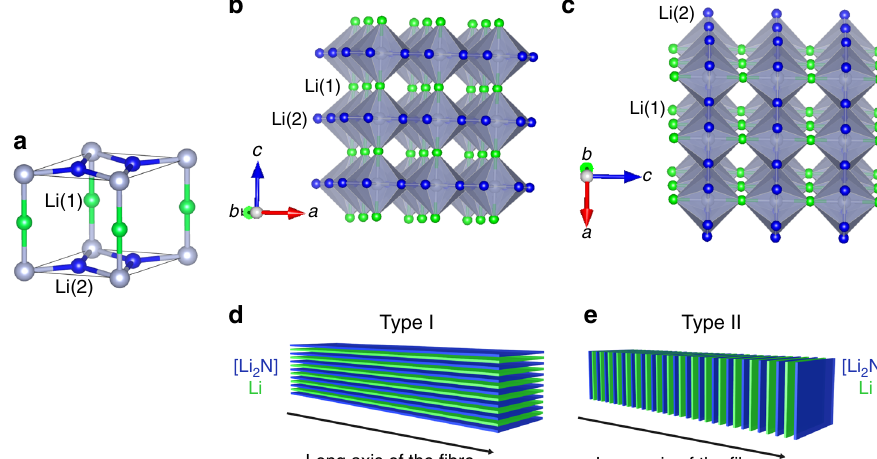
Fig. 3 Schematic diagrams illustrating the Li 3 N crystal structure and type I and type II nano fi bres. a Li 3 N unit cell, showing Li(1) atoms (green spheres), Li(2) atoms (blue spheres) and N (grey spheres); polyhedral representations of Li 3 N showing Li(1) atoms and Li(2) atoms: b aligned in the ab direction and c perpendicular to the ab direction; corresponding depictions of d type I and e type II Li 3 N nano fi bres, based on the orientation of the Li (green) and [Li 2 N] layers (blue) with respect to the long axis of the fi